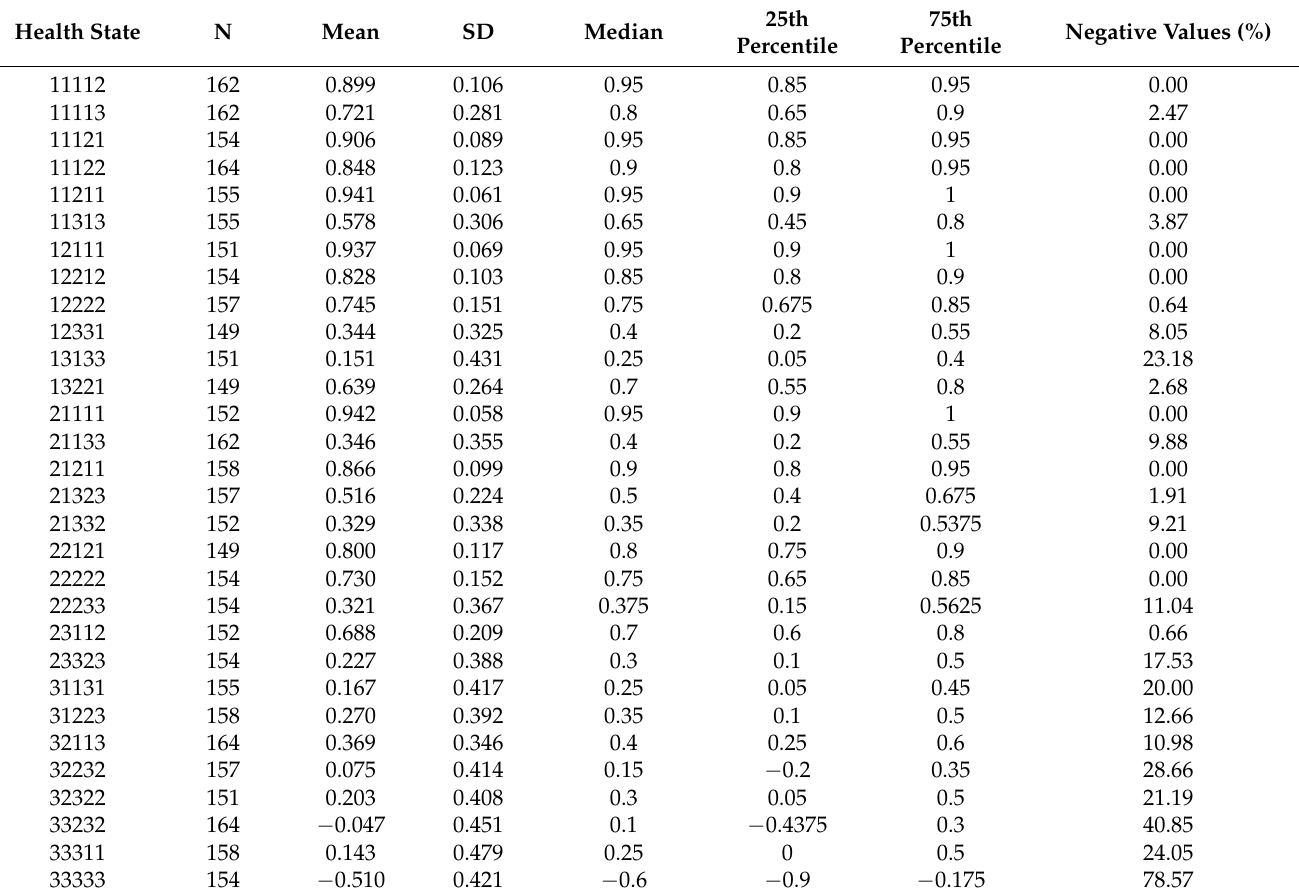
Table 3. Descriptive statistics for observed cTTO values (V3